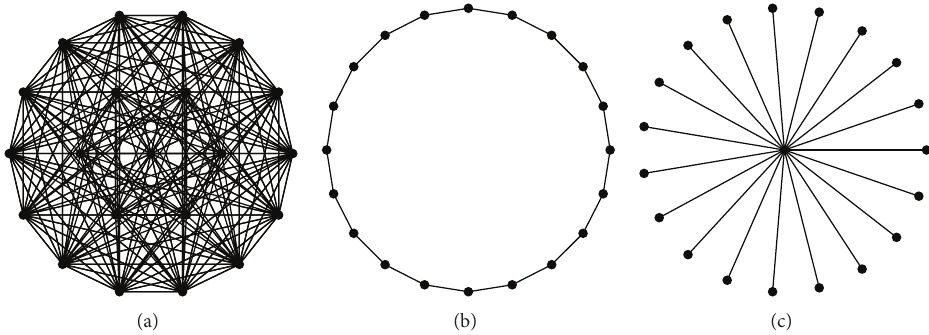
Figure 1: (a) Fully connected topology; (b) ring topology; (c) star